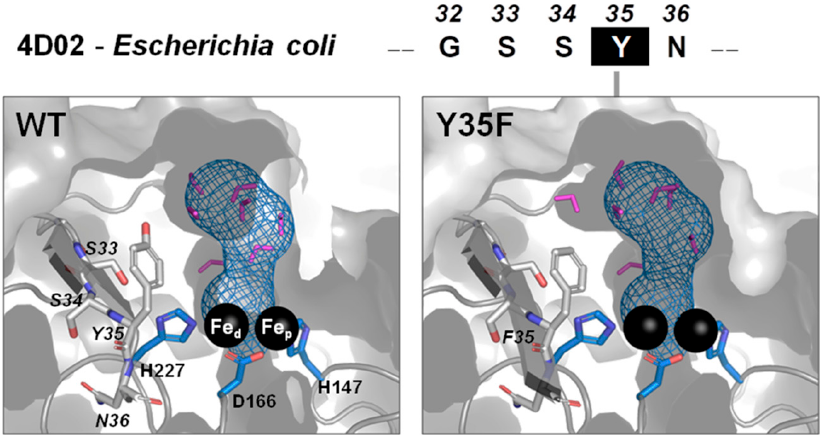
Figure 8. Homology-based model of the Y35F mutant. The figure was built with PyMOL using the X-ray structure for the wt enzyme (PDB code: 4D02) and the structure corresponding to the best model generated for the mutant; the small channel is represented as blue mesh determined using MOLE [28]. The protein’s secondary structure elements are shown using a gray cartoon representation and the molecular surface is also represented in gray. Only some residues coordinating the metal center, His227, Asp166 and His147, are displayed, using sticks with the carbons colored in blue and the iron atoms represented as black spheres, labeled as proximal Fe (Fe p ) and distal Fe (Fe d ). The water molecules predicted by Dowser++ [32] are depicted as pink sticks. The double mutant S33V_S34V combined the effects of the individual mutations S33V and S34V and, thus, was predicted to affect both the interactions with His171 and His127 and the hydration of the small cavity. Interestingly, there was a correlation be- tween the effect of the mutations on the hydration of the small cavity and the effect on the